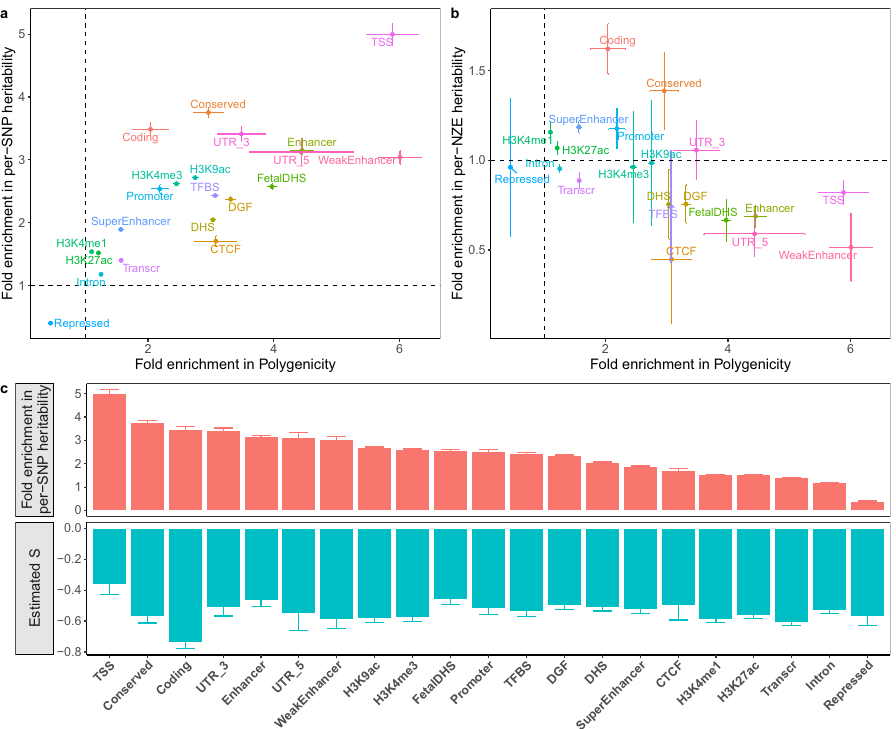
Fig. 6 Characterisation of the genetic architecture in 21 functional genomic annotation categories using the two-component SBayesS-strat model. a Fold enrichment of per-SNP heritability against that of polygenicity. b Fold enrichment of per-NZE (per-nonzero effect) heritability against that of polygenicity. Colours indicate different annotation categories. c Estimated S (green) across annotation categories ranked by per-SNP heritability enrichment (red). Each dot or histogram is the median across 35 UKB traits (including diseases). Each bar indicates the standard error of the